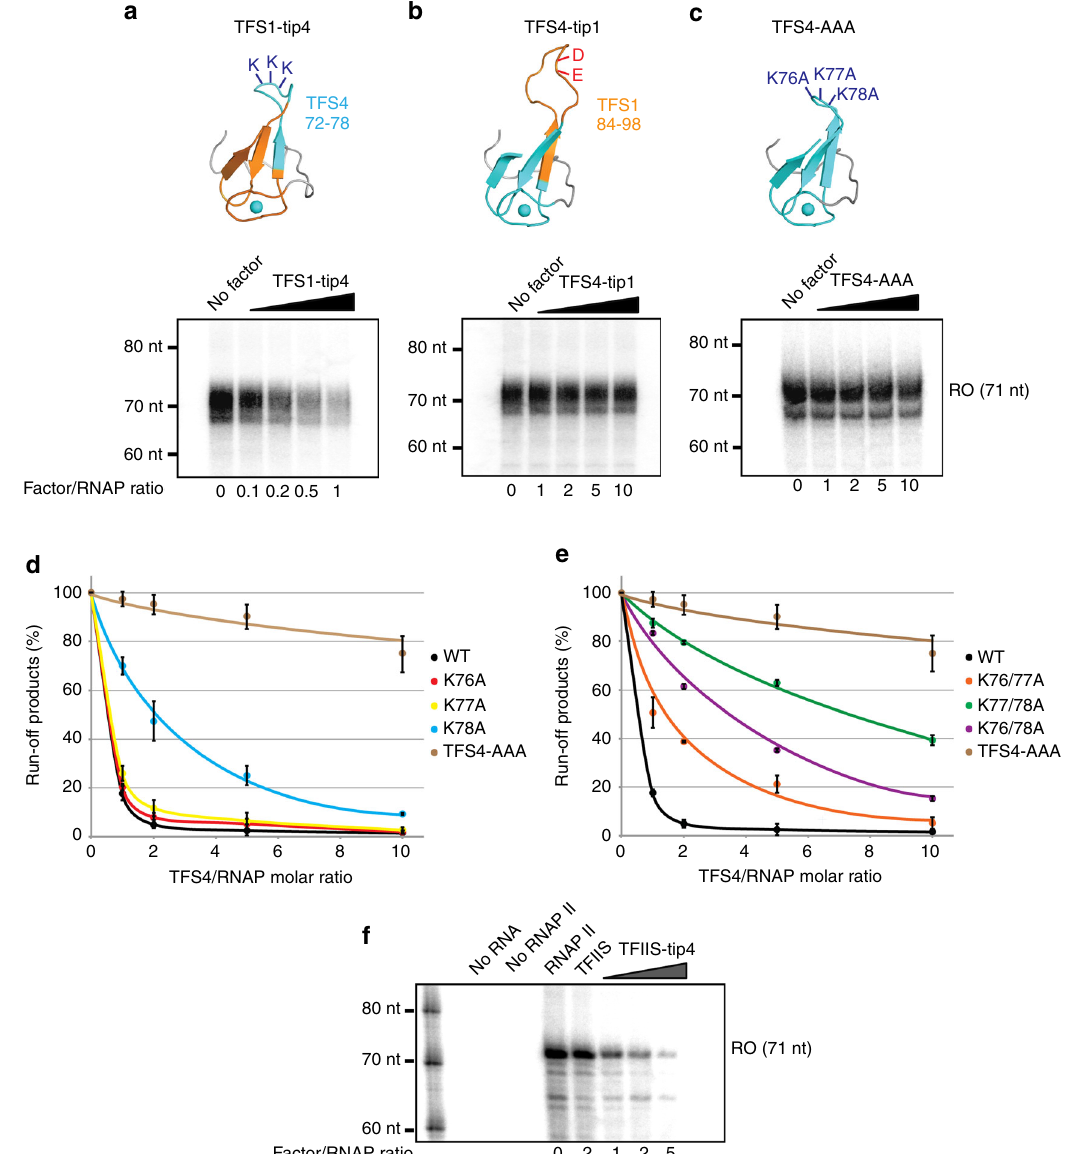
Fig. 5 Functional activities of chimeric TFS1/TFS4 hybrid- and alanine substitution mutants. a – c Structural models of TFS1-tip4, TFS4-tip1 and TFS4-AAA mutants and their inhibitory activity in transcription elongation assays (panels below the structural models). d , e Quanti fi ed run-off transcript signals from transcription elongation assays carried out in the presence of TFS4 variants with single ( d ) and double alanine substitution ( e ) of the three lysine residues in the C-ZR. Error bars represent standard deviation from three technical repeats. f Transcription elongation assays with yeast RNAP II and its response to yeast TFIIS or